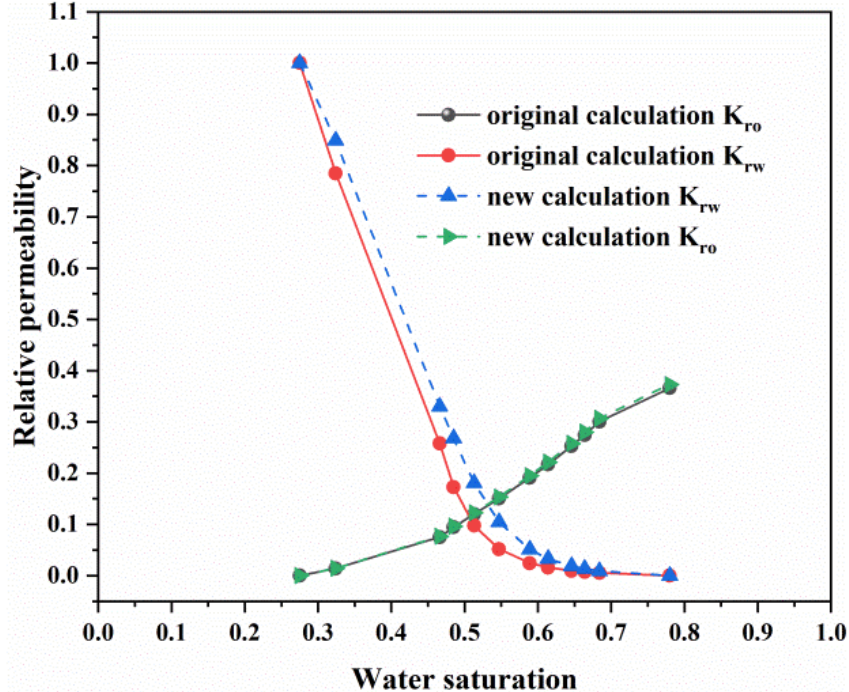
Figure 2. Comparison of oil – water relative permeability curves of the two models.